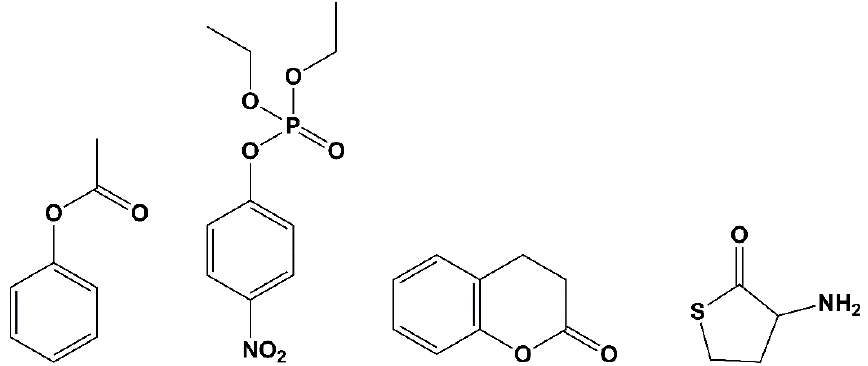
Figure 1. PON1 substrates from left to right: phenyl acetate, paraoxon, dihydrocoumarin and homocysteine thiolactone.